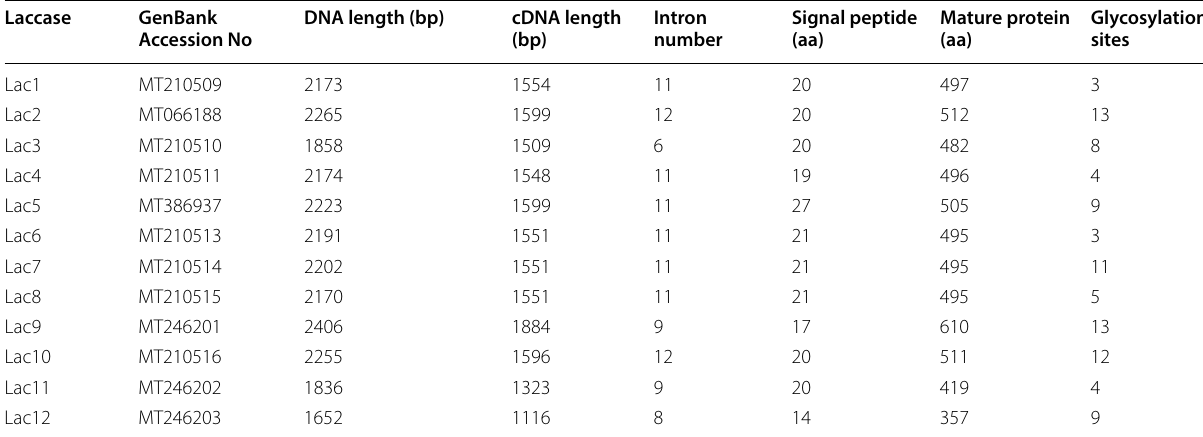
Table 1 The C. unicolor CGMCC 5.1011 laccase gene family